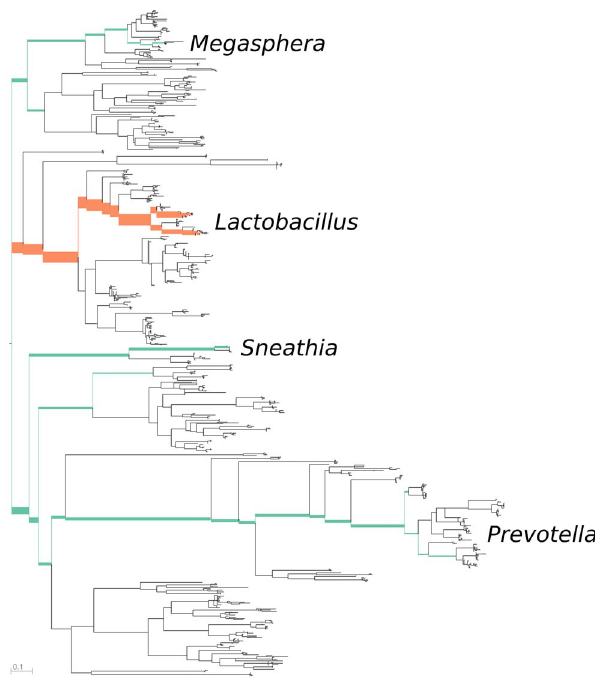
Figure 4. The first principal component for the combined vaginal data, representing about 56 percent of the variance. The reference tree is colored by principal component sign (positive colored orange, negative colored green) and thickened proportional to magnitude. The edges across which maximal between-sample hetero- geneity is found are those leading to the Lactobacillus clade and those leading to the Sneathia and Prevotella clade. This axis corresponds to taxa that are important in the diagnosis of bacterial vaginosis, as Sneathia and Prevotella are associated with bacterial vaginosis, while Lactobacillus is associated with a healthy microbiome.